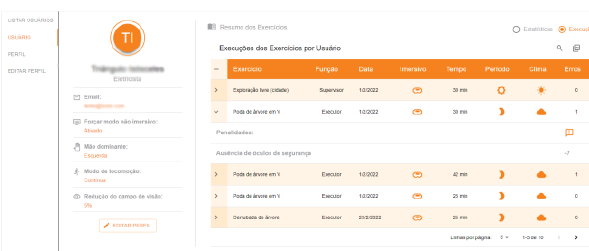
Figure 18. Report of tries of exercises by teams on the Web-based sys- tem.